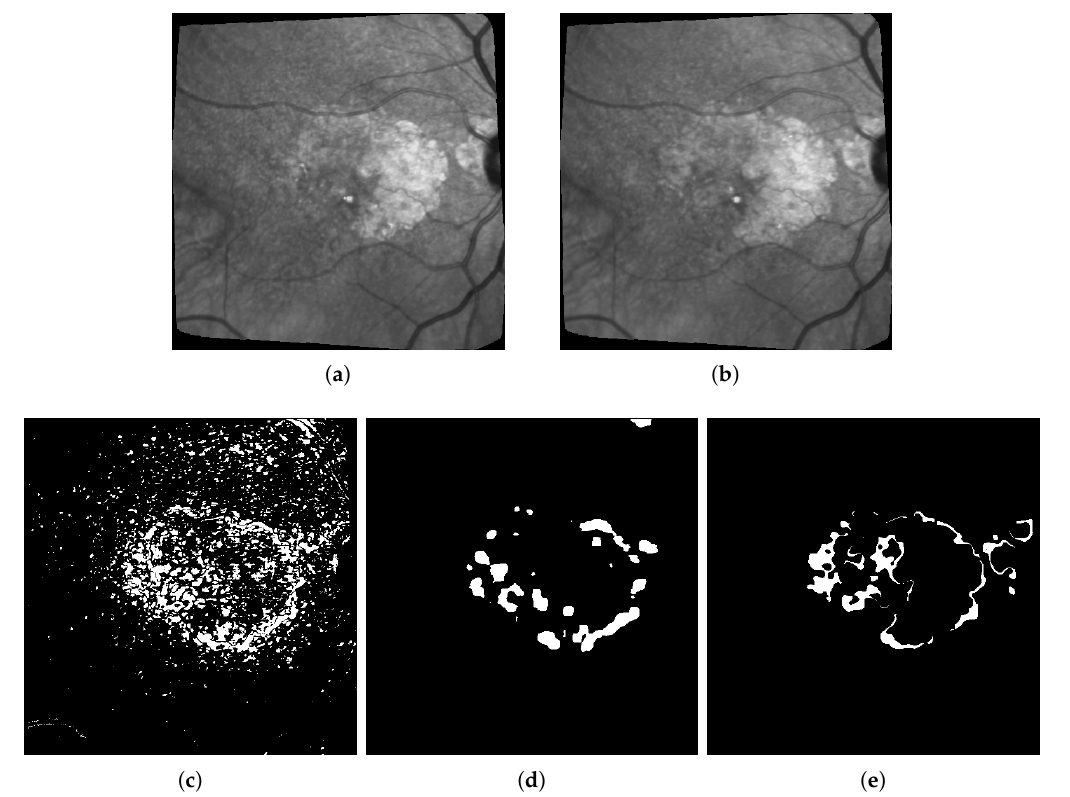
Figure 8. Difference + Otsu thresholding vs. our approach (AE) on patient 003. ( a ) Image at t = 0; ( b ) Image at t + 3 months; ( c ) Raw difference and Otsu thresholding, F1 score = 0.26; ( d ) Our method, F1 score = 0.36; ( e ) Proposed ground